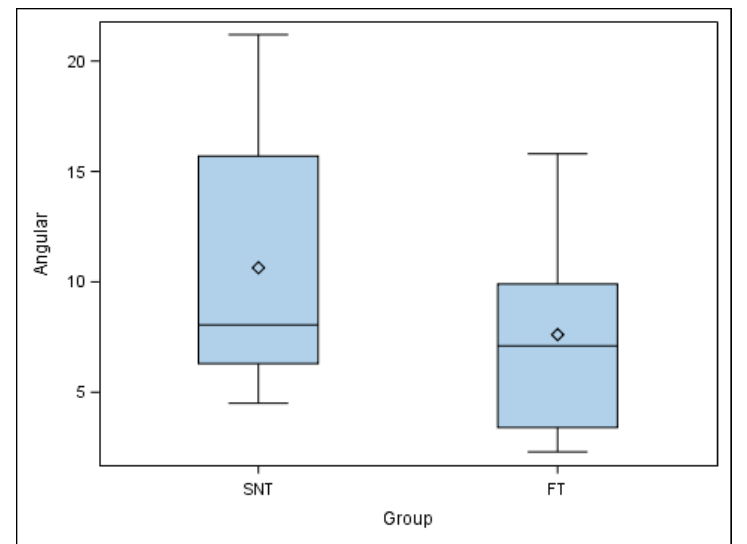
Figure 8. Box plot of the angular deviation of the autotransplanted teeth. The horizontal line in each box represents the respective median value of the study groups. ◊ : Mean value of the box plots.